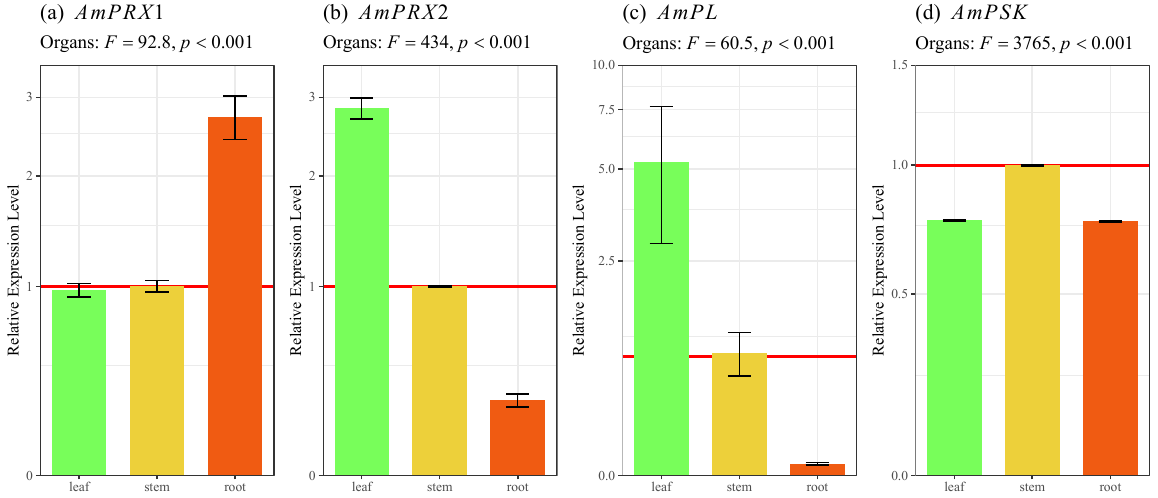
gene displayed comparable transcript levels among leaves, stems, and roots (Figure 3d).